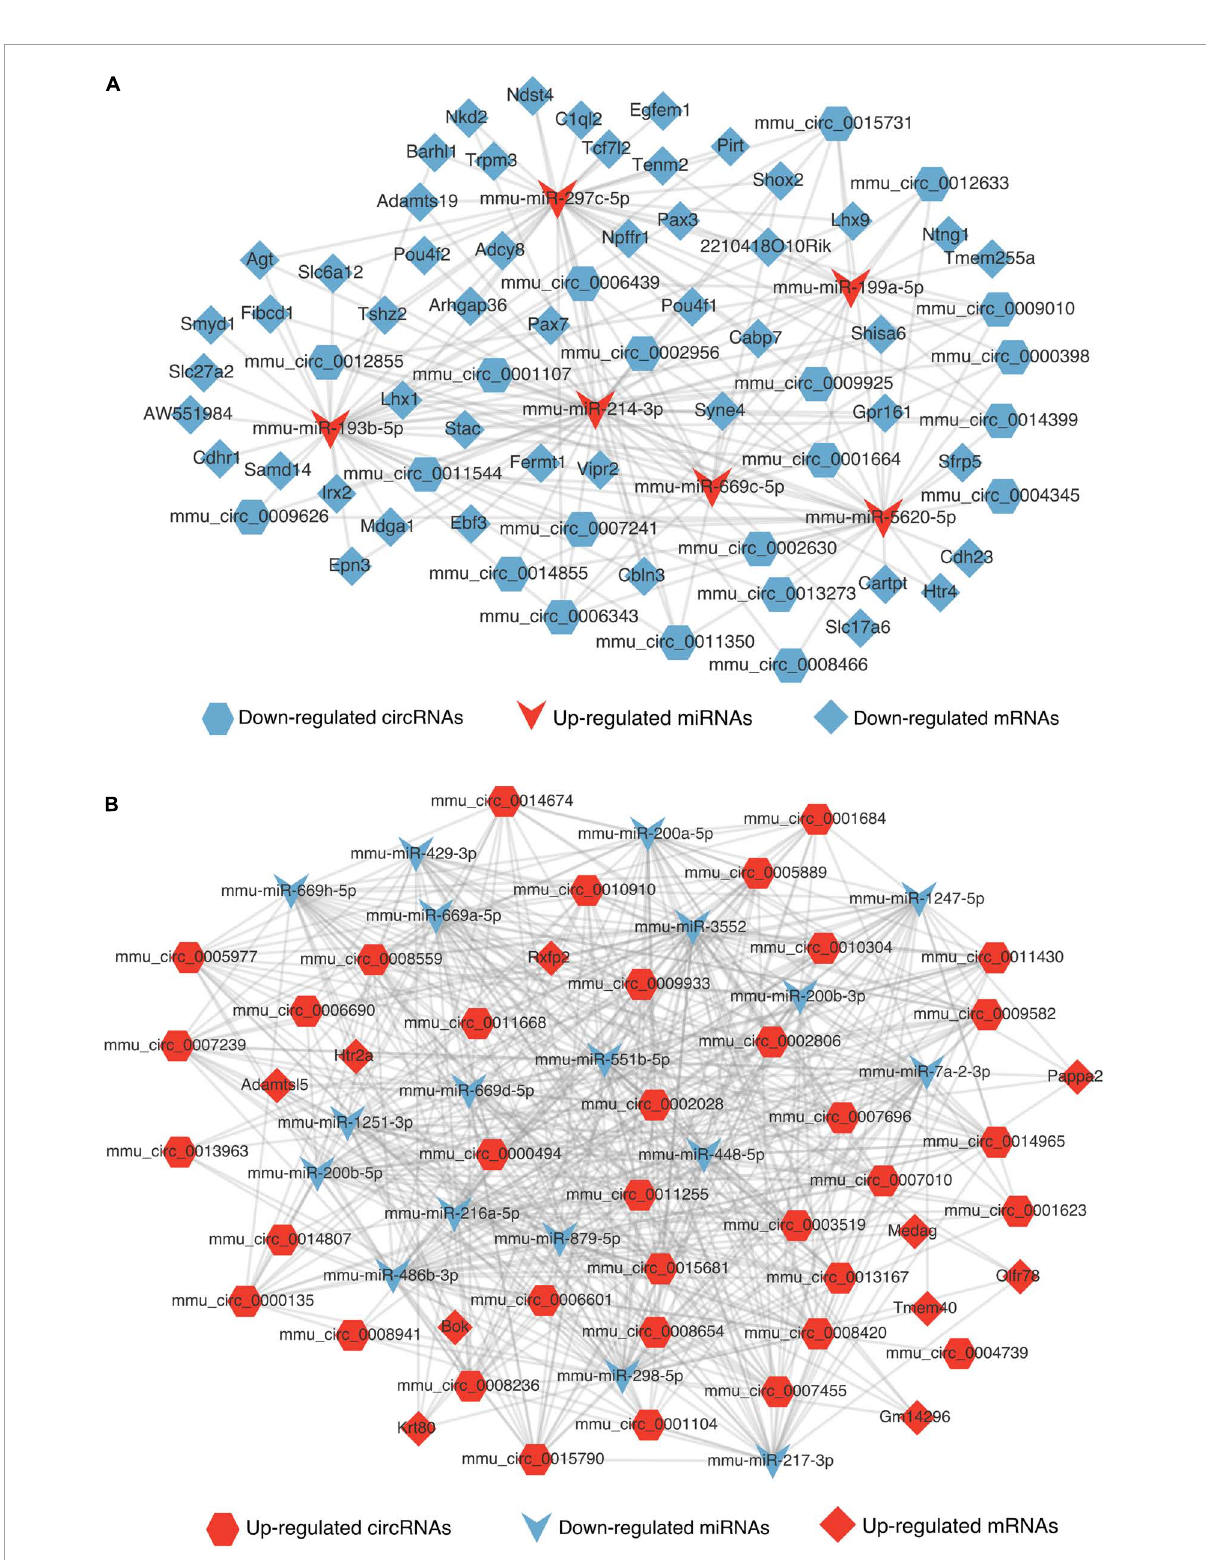
FIGURE8 The competing endogenous RNA networks of DEcricRNA. (A) The competing endogenous RNA network of the decreased DEcircRNAs. (B) The competing endogenous RNA network of the increased DEcircRNAs. Hexagon, V shape, and diamond represent the circRNA, miRNA, and mRNA, respectively. Red represents up-regulated and blue represents